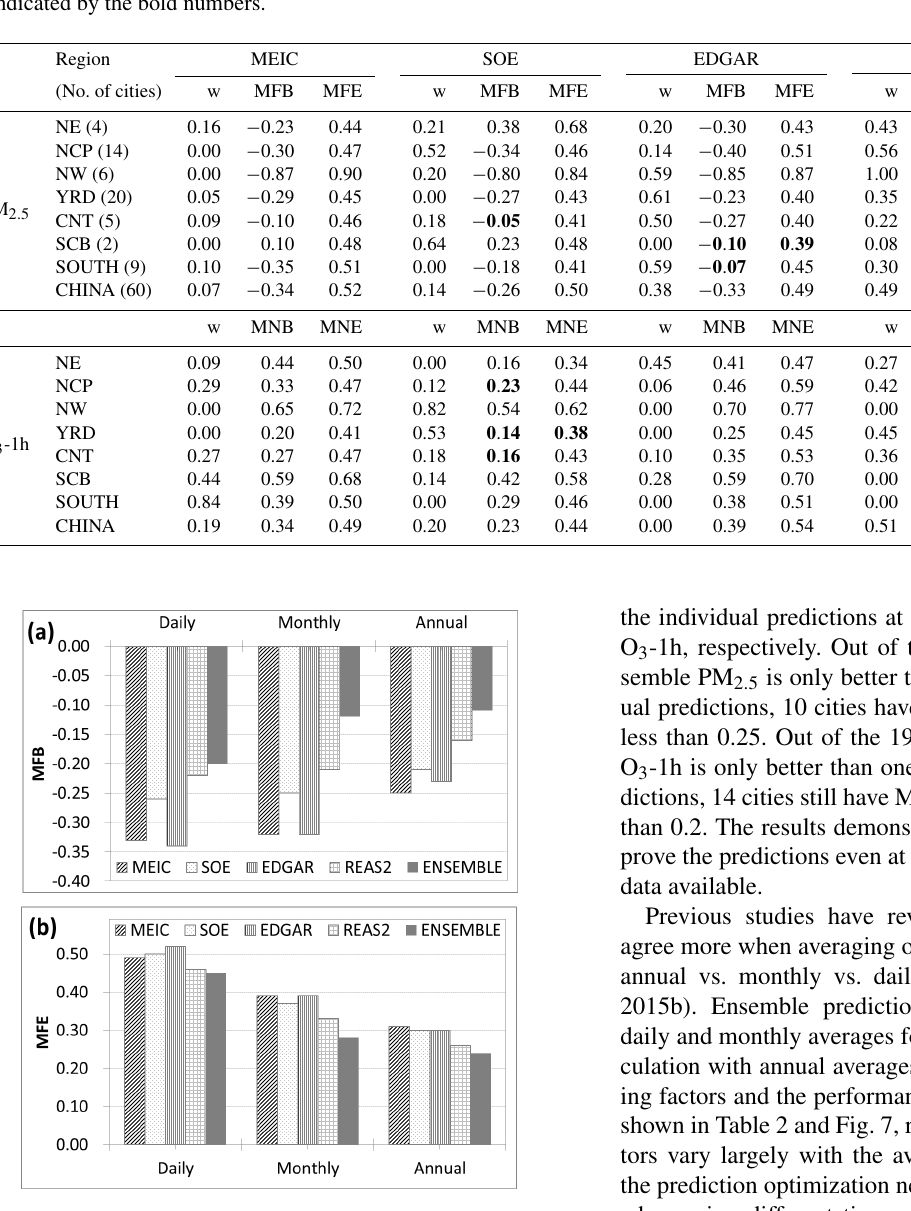
Figure 7. MFB (a) and MFE (b) of predicted PM 2 . 5 for with an averaging time of 24h, 1 month, and 1 year based on the individual inventories and the